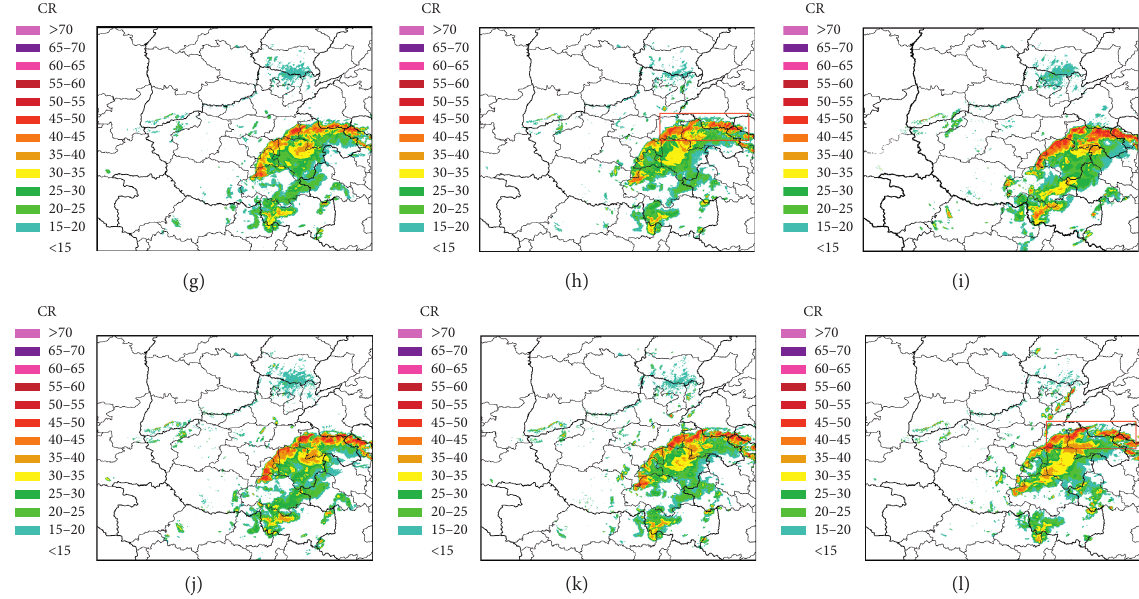
Figure 8: Comparison between the composite reflectivity factor forecast results and the actual weather conditions for the 2h starting at 0400UTC August 1 2017. The forecast results of the optical flow method: (a) 30min, (b) 60min, (c) 90 min, and (d) 120min after the start time of 1100UTC, respectively; the forecast results of the ConvLSTM method: (e) 30min, (f) 60 min, (g) 90min, and (h) 120min after the start time of 1100UTC, respectively; the actual weather conditions: (i) 30min, (j) 60 min, (k) 90min, and (l) 120min after the start time of 1100UTC, respectively; red square lines represents the area where the predicted radar echoes of ConvLSTM are closer to the observation than the prediction of the optical flow